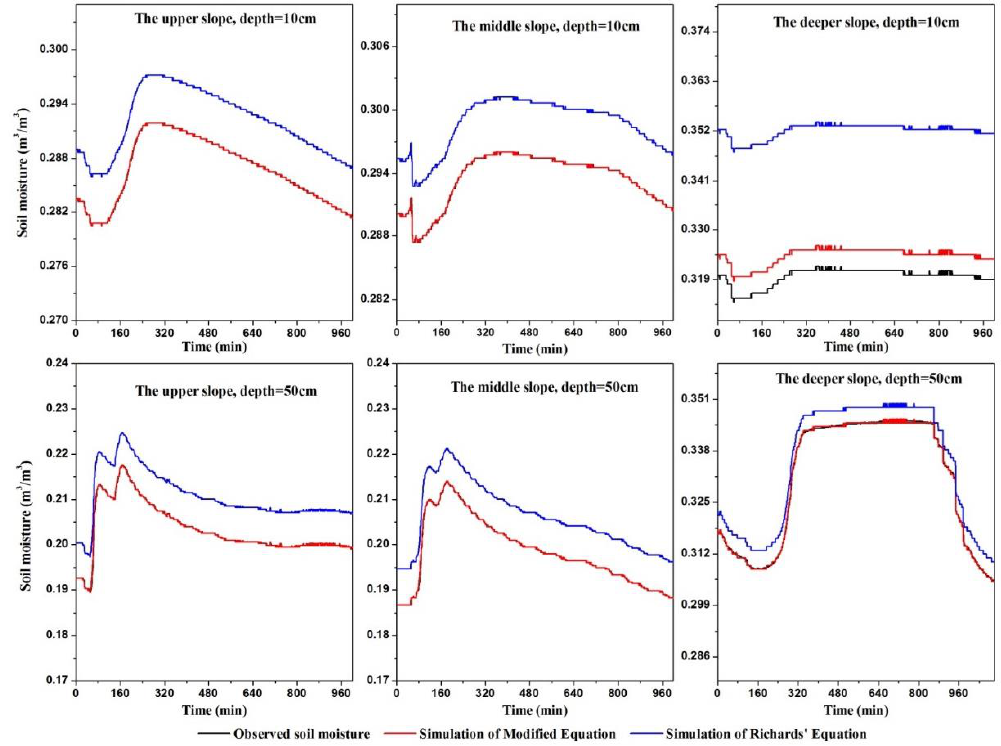
Figure 5. Comparisons of the simulation results among different slope position. The depth is from 10 to 50 cm.